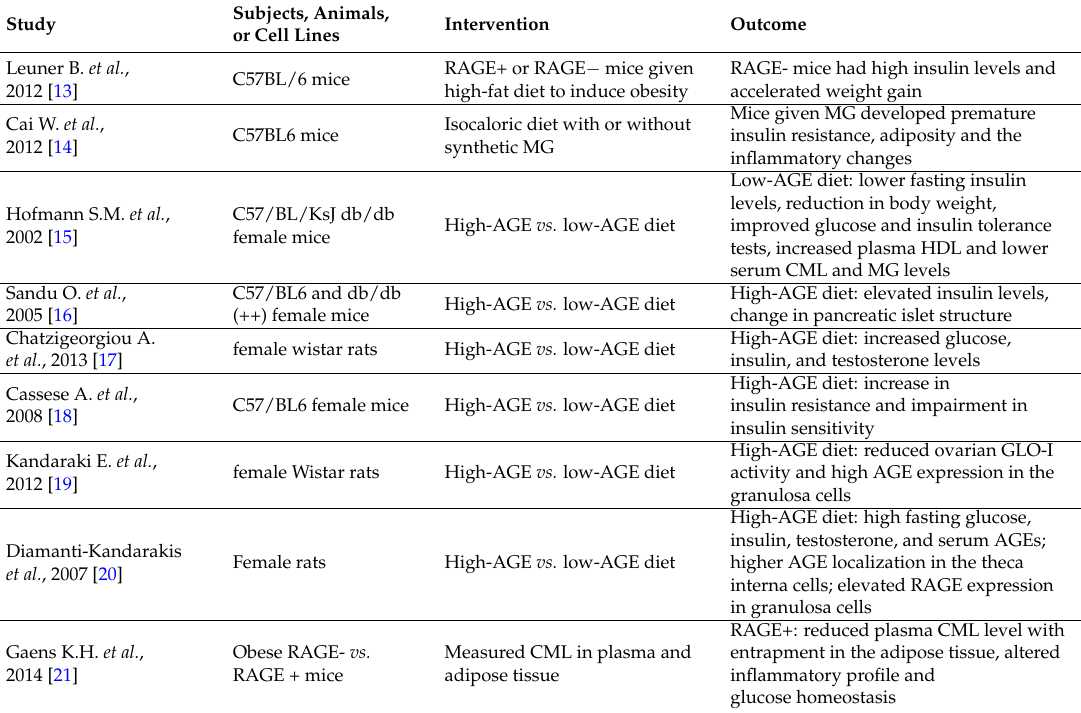
Figure 1. Possible Roles of dietary AGEs in PCOS. Table 1. Role of dietary AGEs in metabolic and hormonal dysfunction.